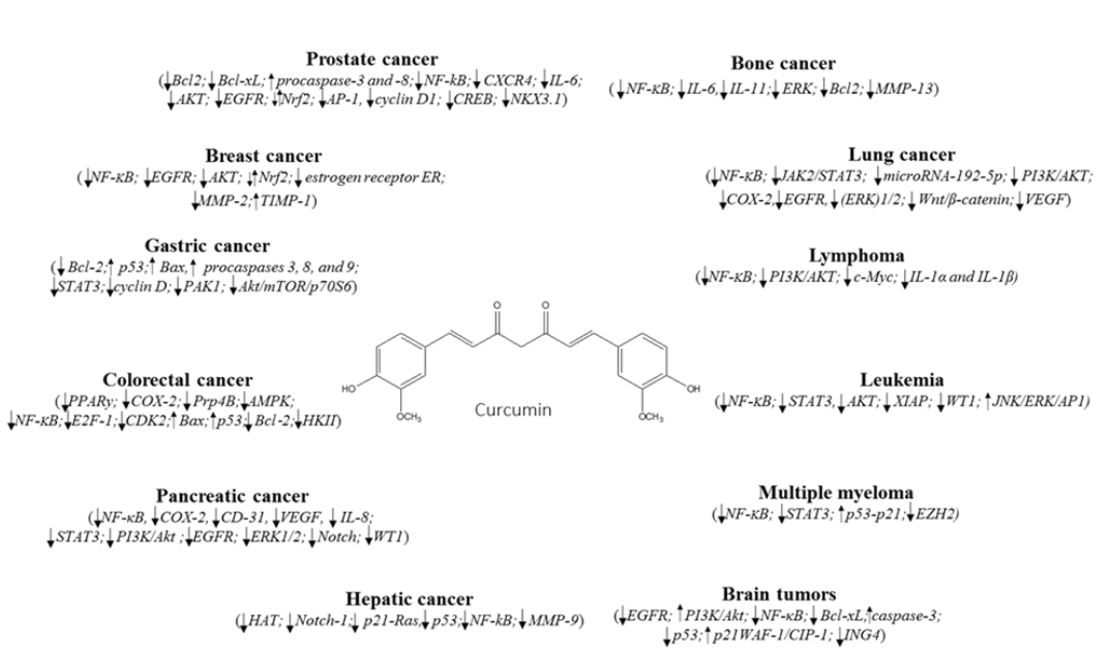
Figure 1. Cell signaling pathways targeted by curcumin in different cancers. ↓ Downregulation / inhibition; ↑ Upregulation / activation; Modulation.